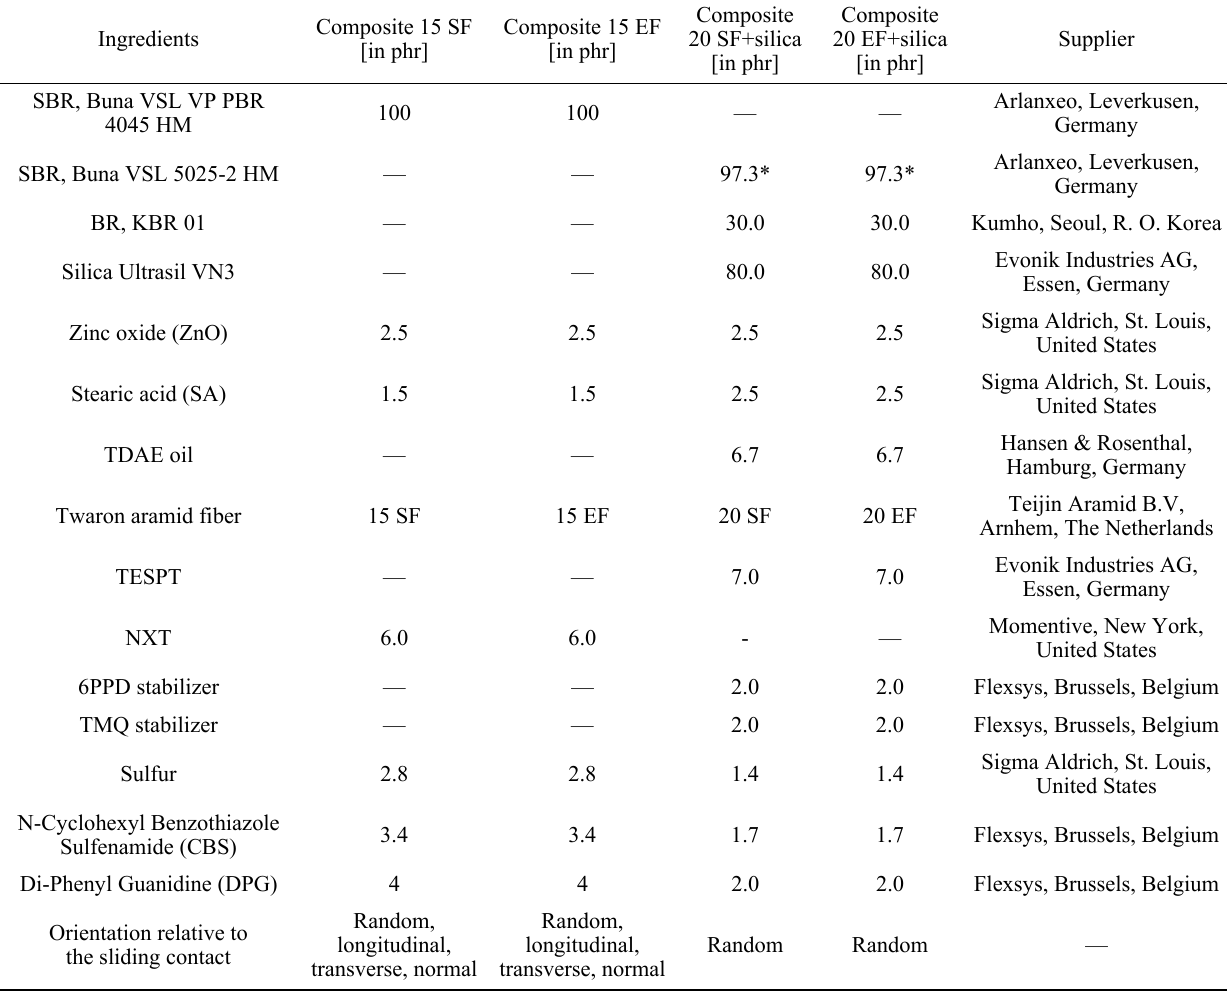
Table 1 Material formulation of the composites.